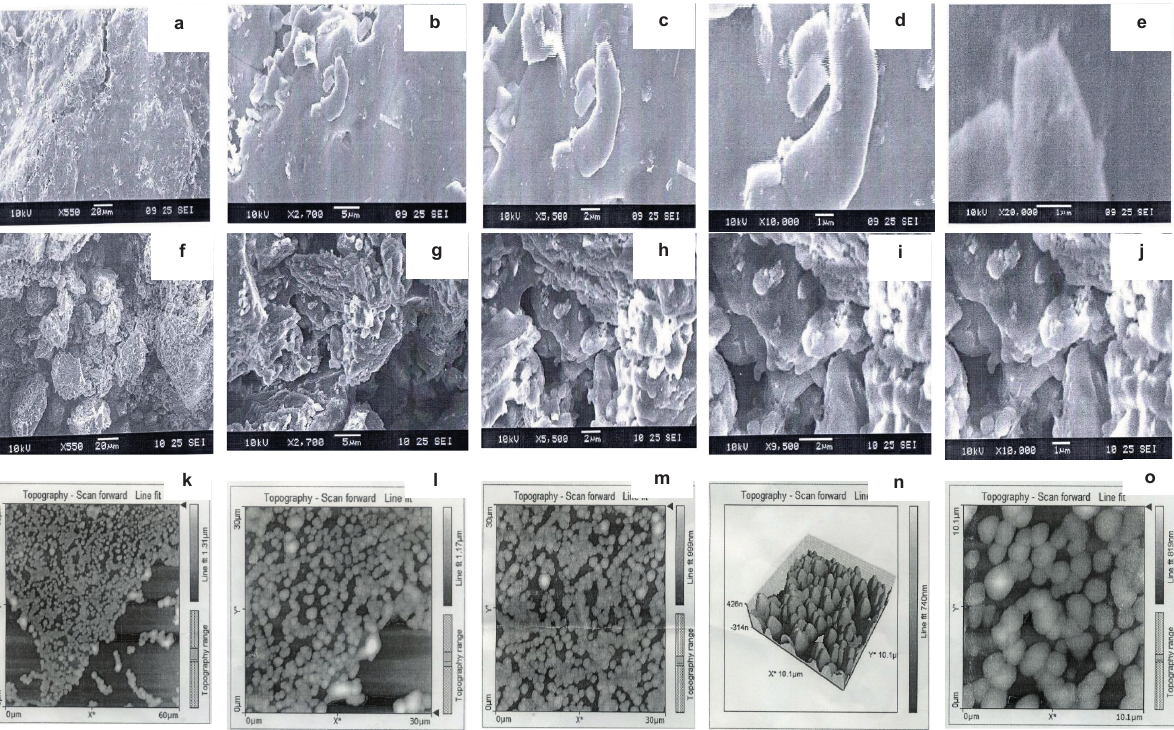
, f-j) P. cerasifera mediated ZnO ℃